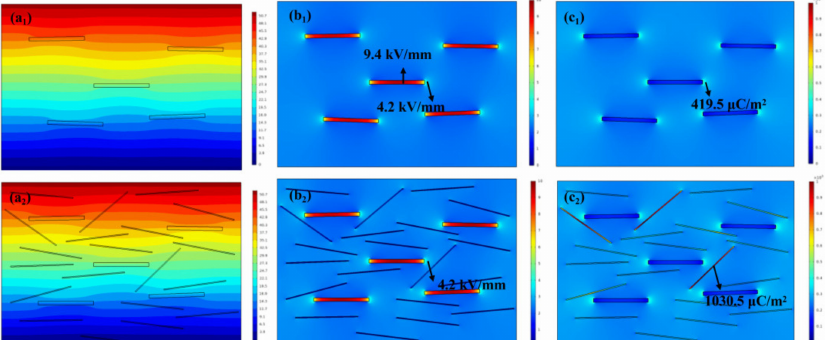
Figure 8. Finite element simulation of electrical potential of ( a 1 ) PVDF/BN@PDA and